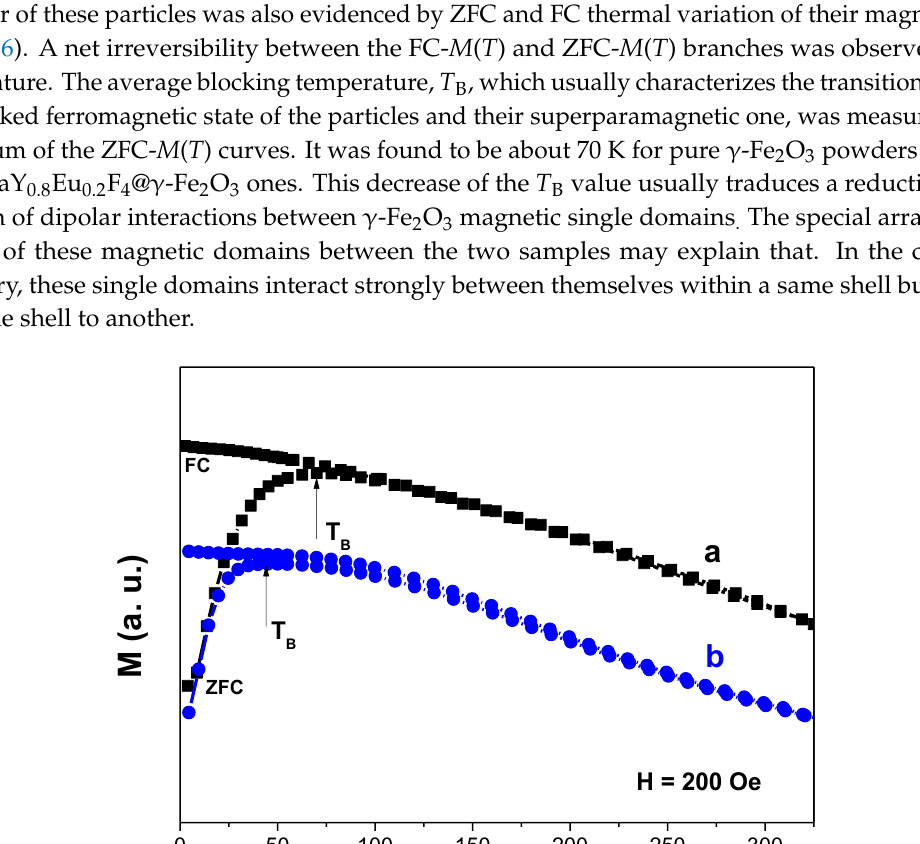
Figure 6. Zero field cooling (ZFC-) and field cooling (FC)- M ( T ) curves recorded on the ( a ) as-produced γ-Fe 2 O 3 and ( b ) β-NaY 0.8 Eu 0.2 F 4 @γ-Fe 2 O 3 particles. The same magnetic measurements were performed on dried citrate–coated β-NaY 0.8 Eu 0.2 F 4 @γ-Fe 2 O 3 nanoparticles (not shown) and the same superparamagnetic behavior was